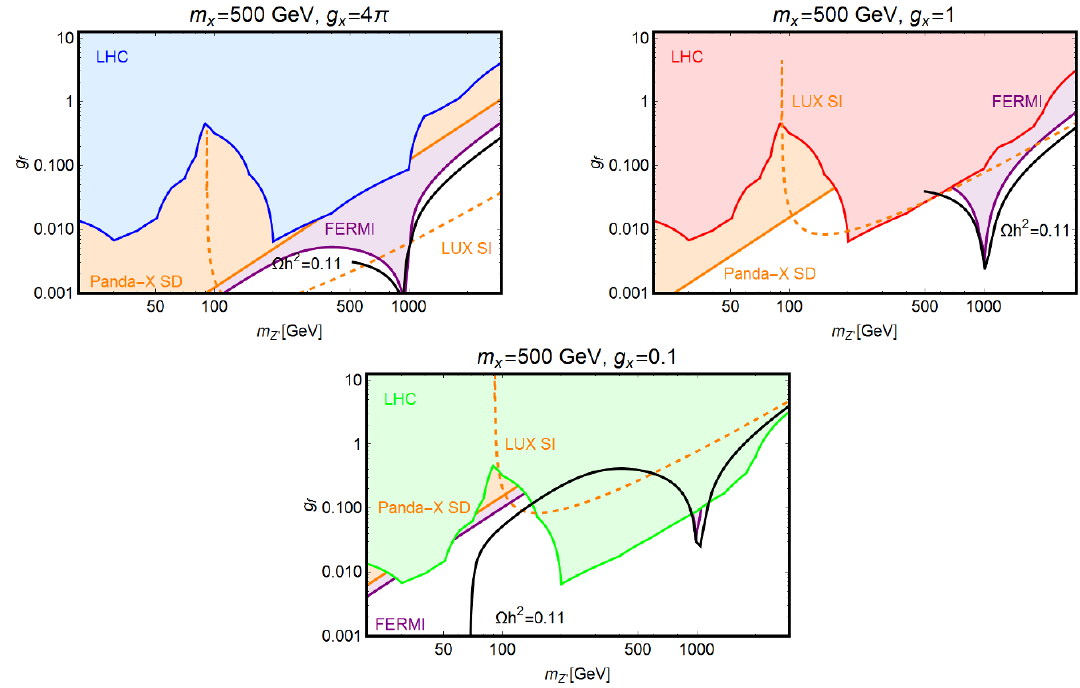
Figure 6 . Results for m (cid:31) = 500 GeV and g (cid:31) = 4 (cid:25); 1 and 0 : 1. Combined upper bounds on the model under study, in the plane ( m Z 0 ; g f ) for the a given DM mass m (cid:31) and coupling g (cid:31) , as reported in the di(cid:11)erent panels. The black lines delimit the correct relic density parameter space. The blue, red and green regions are excluded by LHC data. The orange region represents spin-dependent PANDA-X exclusion region, whereas the dashed curve the spin-independent LUX limit; (cid:12)nally the purple region indicates the FERMI-LAT